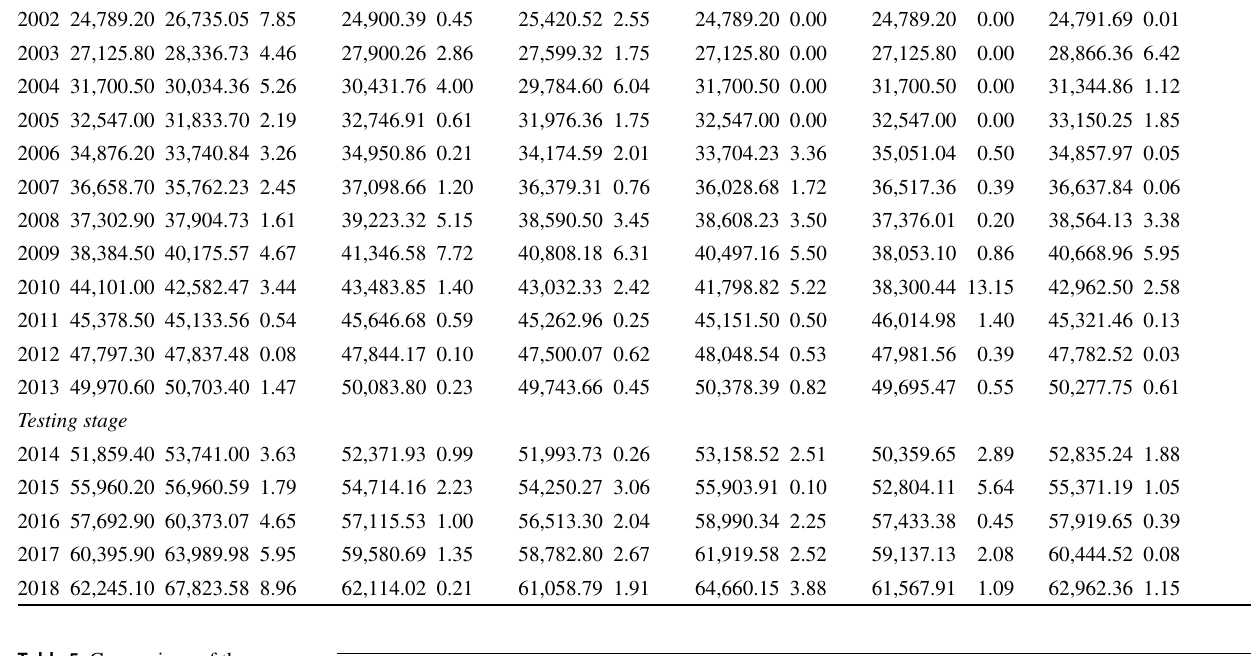
Table 5 Comparison of the prediction accuracies of the six models